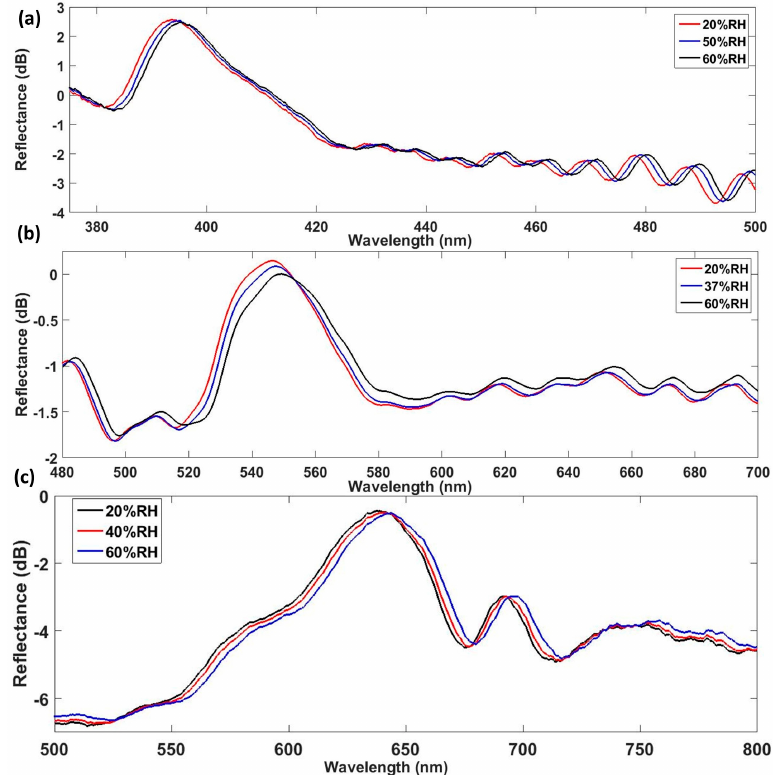
Figure 8. Measured reflected spectra for different RH values obtained with ( a ) device D1, ( b ) device D2, and ( c ) device D3.